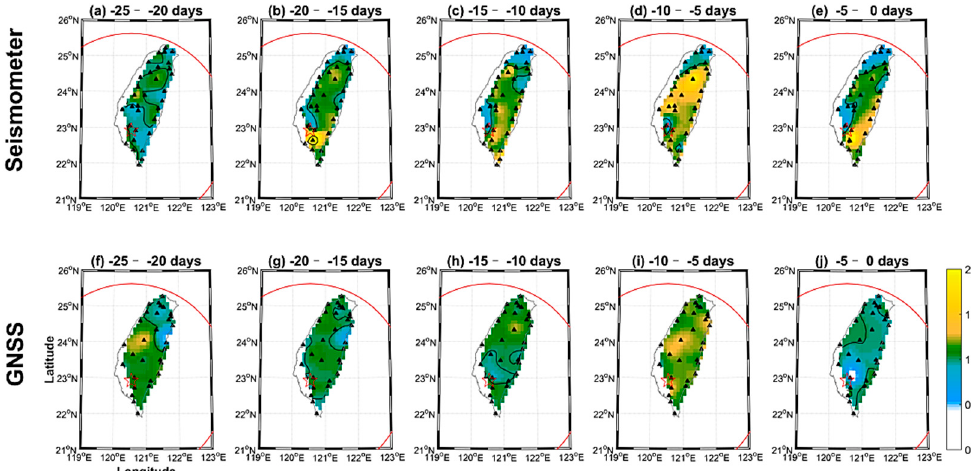
Figure 3. Spatial distribution of amplification ratios computed from data for an interval of 0–25 days before the Meinong earthquake. The upper ( a – e ) and lower ( f – j ) panels denote amplification ratios obtained from seismic and GNSS data. The amplification ratio of > 1 (or < 1) suggests enhancement (or attenuation) of ground vibrations in the particular duration. Time intervals of 5 days were used for the analysis process. The red star denotes the epicenter. Red curves indicate portions of circles with a radius of 300 km from the epicenter of the earthquake.